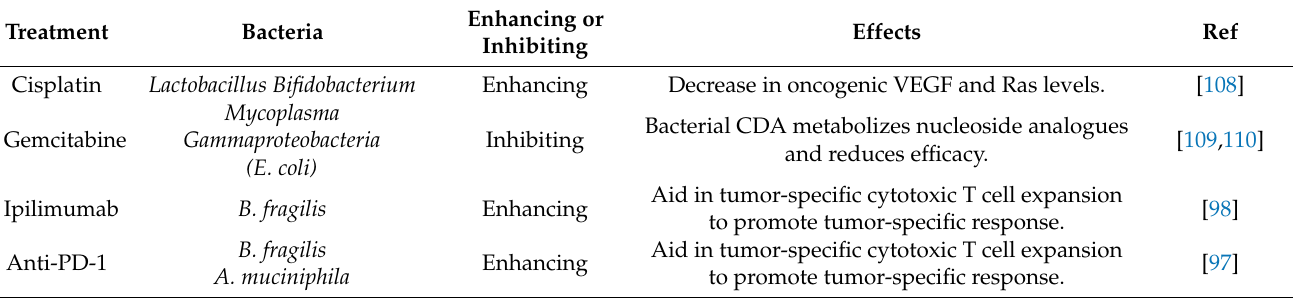
Table 2. Potentiating or inhibitory effects of microbiota on cancer therapy for